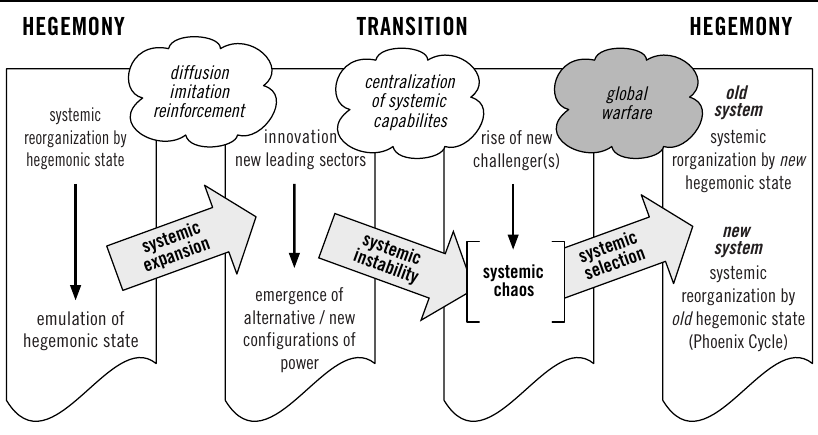
Figure 2 – Dynamics of Systemic Leadership